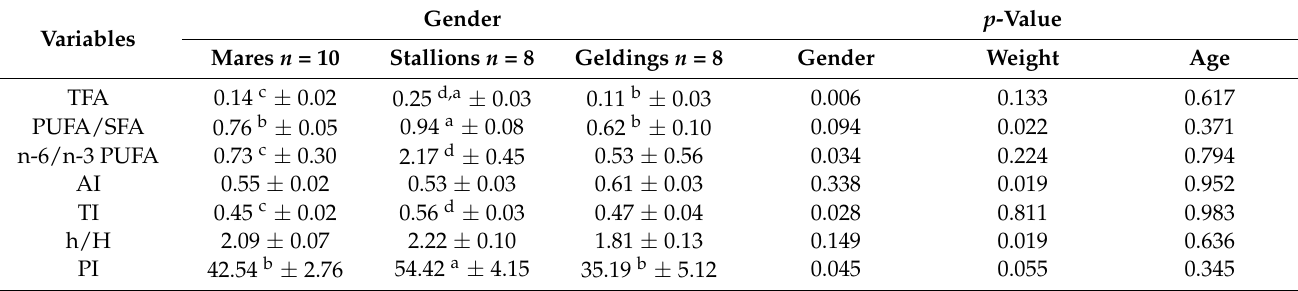
Table 9. Total trans fatty acids and fatty acid ratios and lipid quality indexes in intramuscular fat of horse